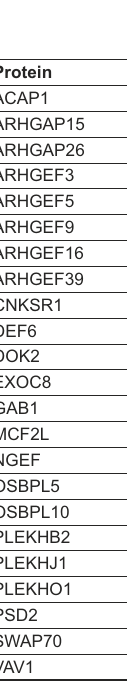
Fig. 2 The presence of PS in lipid vesicles does not affect PIP binding by proteins. a SiMPull was performed for 23 proteins against lipid vesicles containing the indicated PIPs, with or without PS and cholesterol. Binding was observed for all with both types of vesicles. For each condition at least two independent experiments were performed with similar results. Data were analyzed as described for Table 1 and Supplementary Data 1. b Representative TIRF images of EGFP pulldown from a are shown for fi ve proteins that are also shown in Fig. 1c, each by vesicles with or without PS. Scale bars: 5 µ